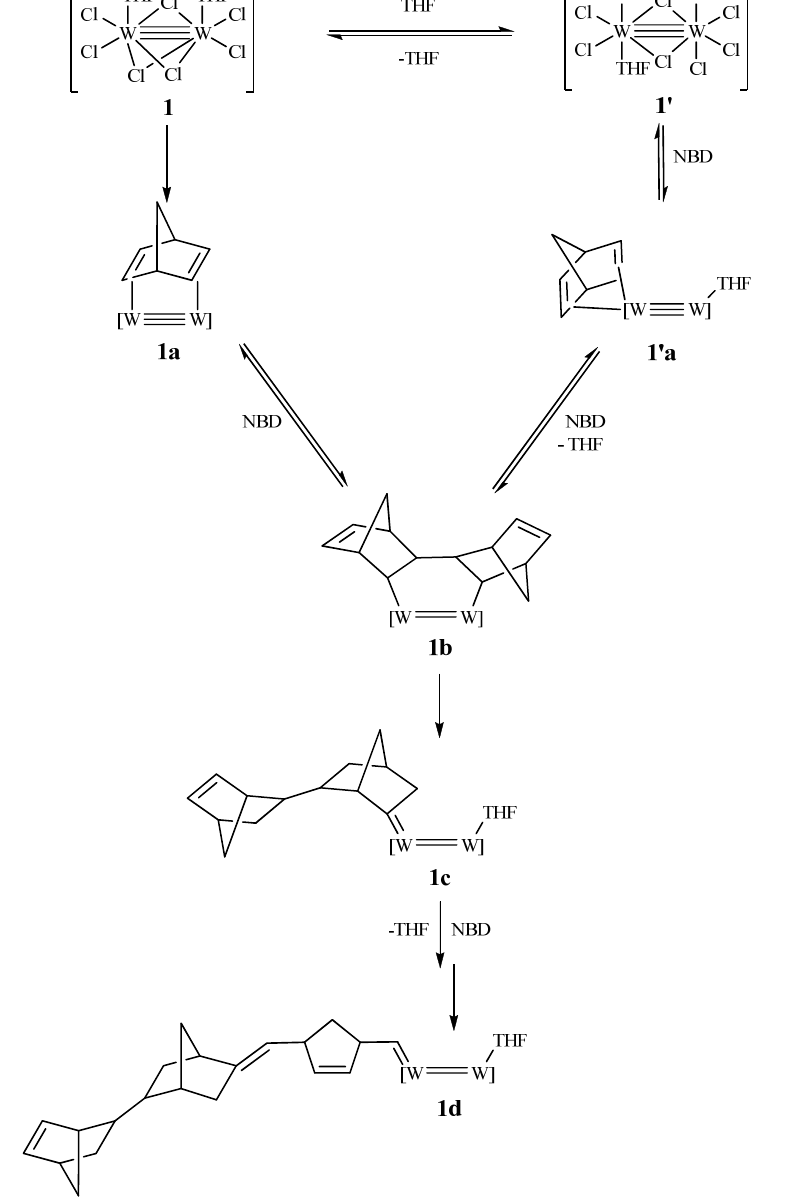
Scheme 2. Schematic view of proposed bimetallic mechanism of polymerization of NBD with complex 1